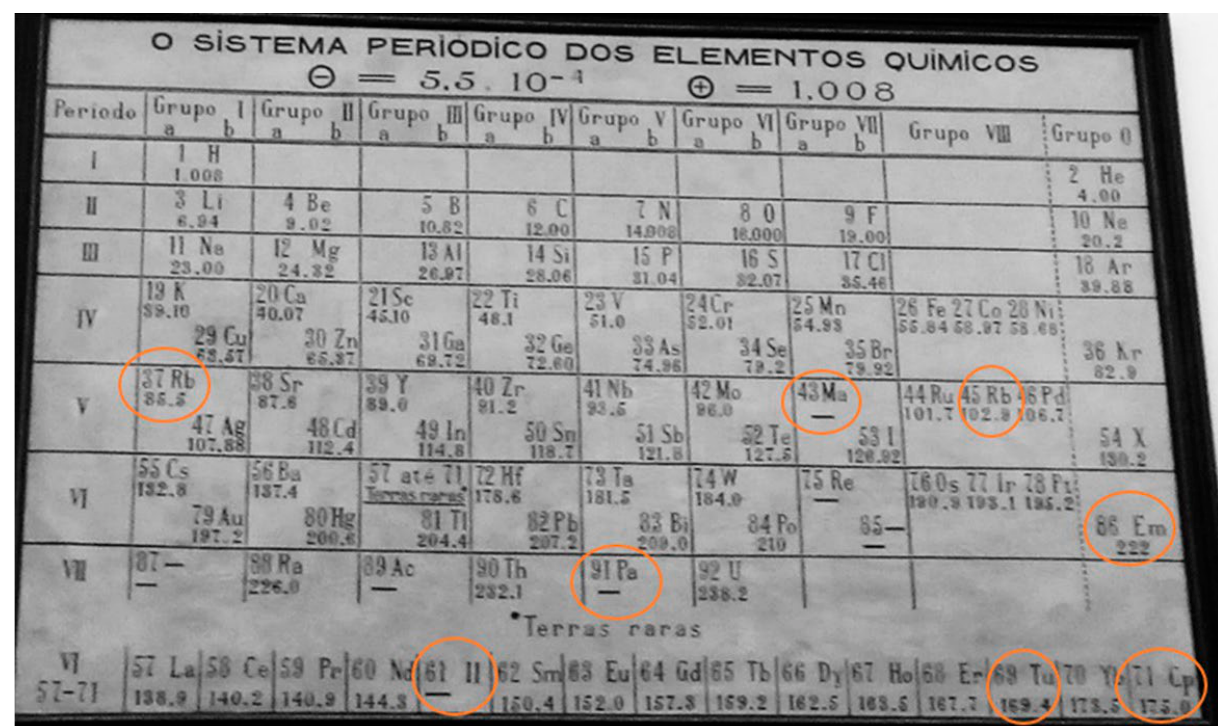
Figure 5. Periodic table in display at the Science Museum, University of Coimbra. Photo by Isabel